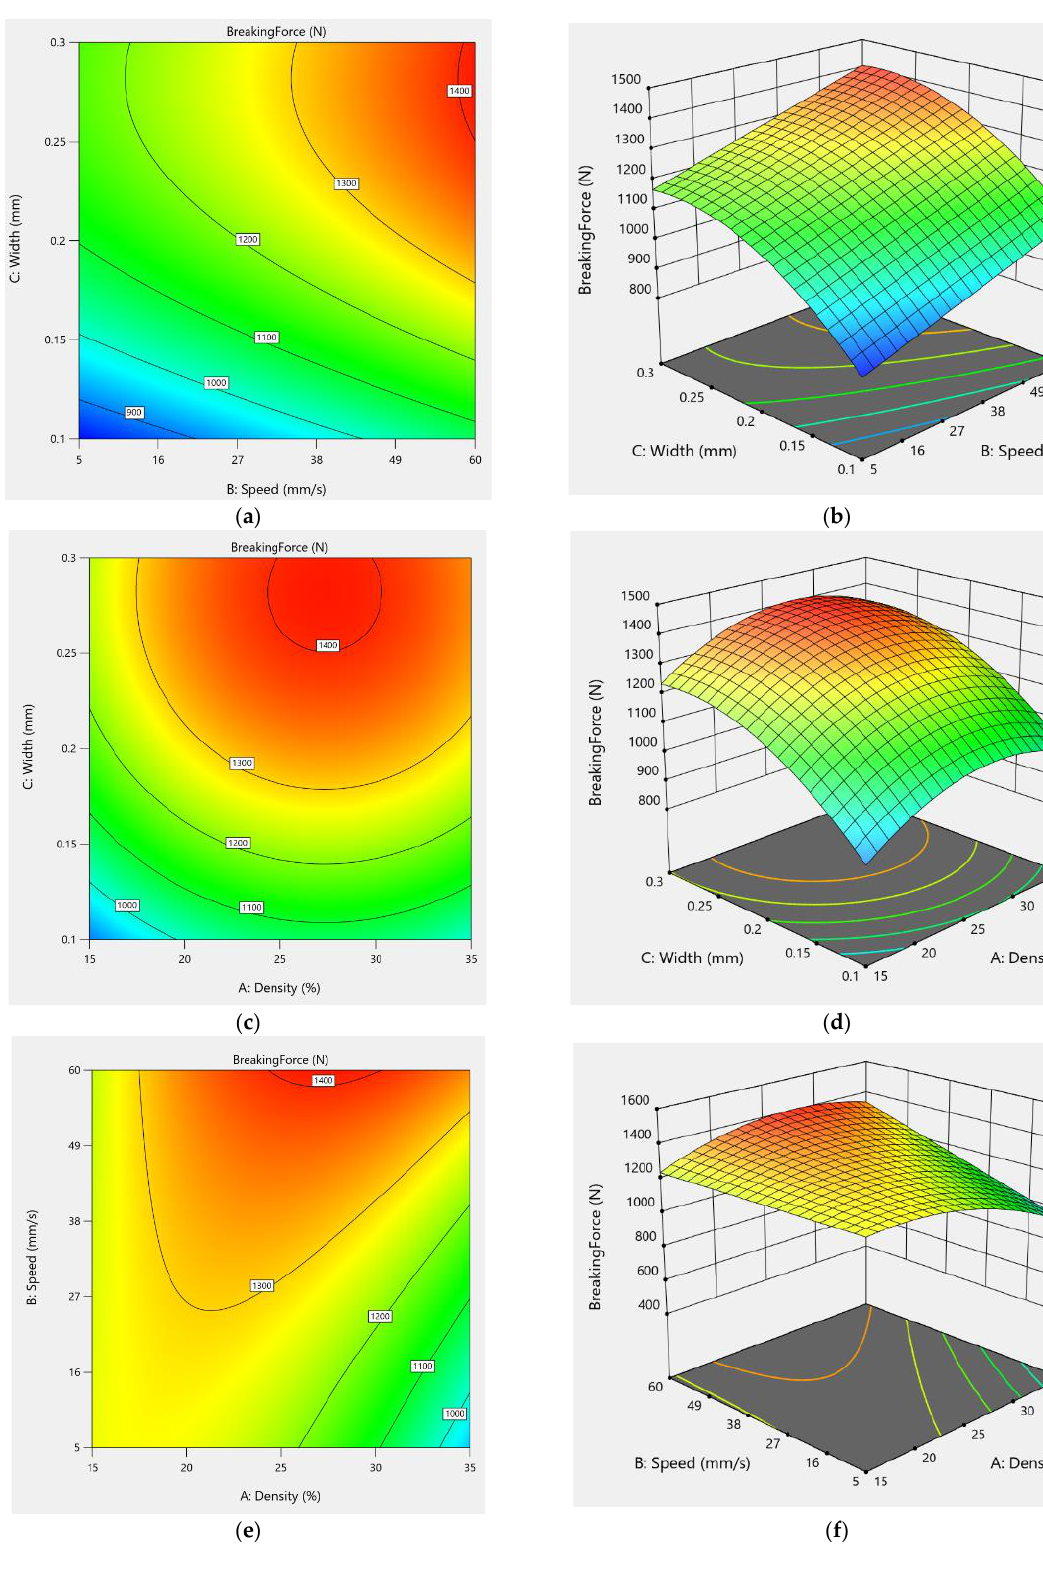
Figure 10. Contour graph based on DoE for the speed and line width with the density of 27.3% ( a ); the corresponding 3D surface plot ( b ), contour graph of the density and the line width at a high speed (60 mm/s) ( c ); the corresponding 3D surface plot ( d ); contour graph of the density and the speed with a line width of 0.28 mm ( e ); the corresponding 3D surface plot ( f